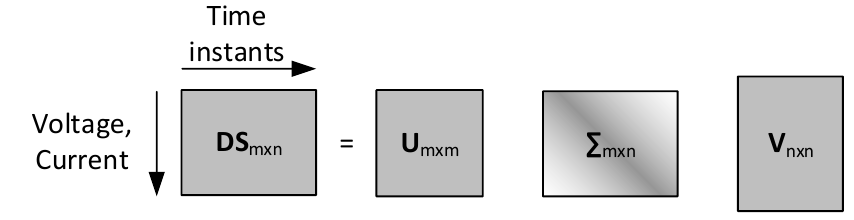
Figure 5. SVD of data matrix DS